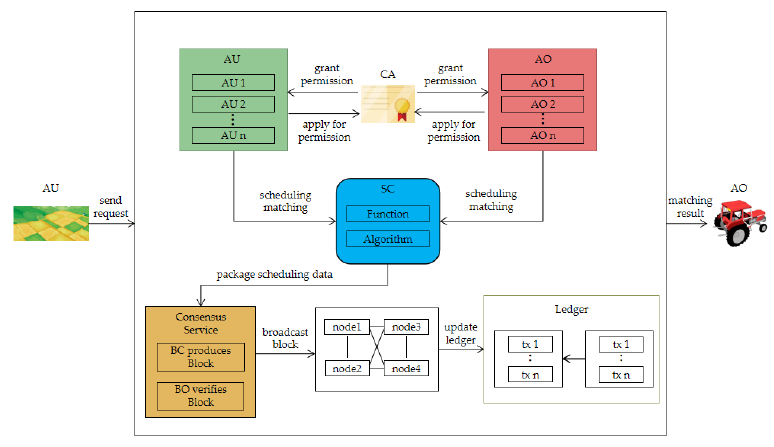
Figure 2. Interactive structure of the system.